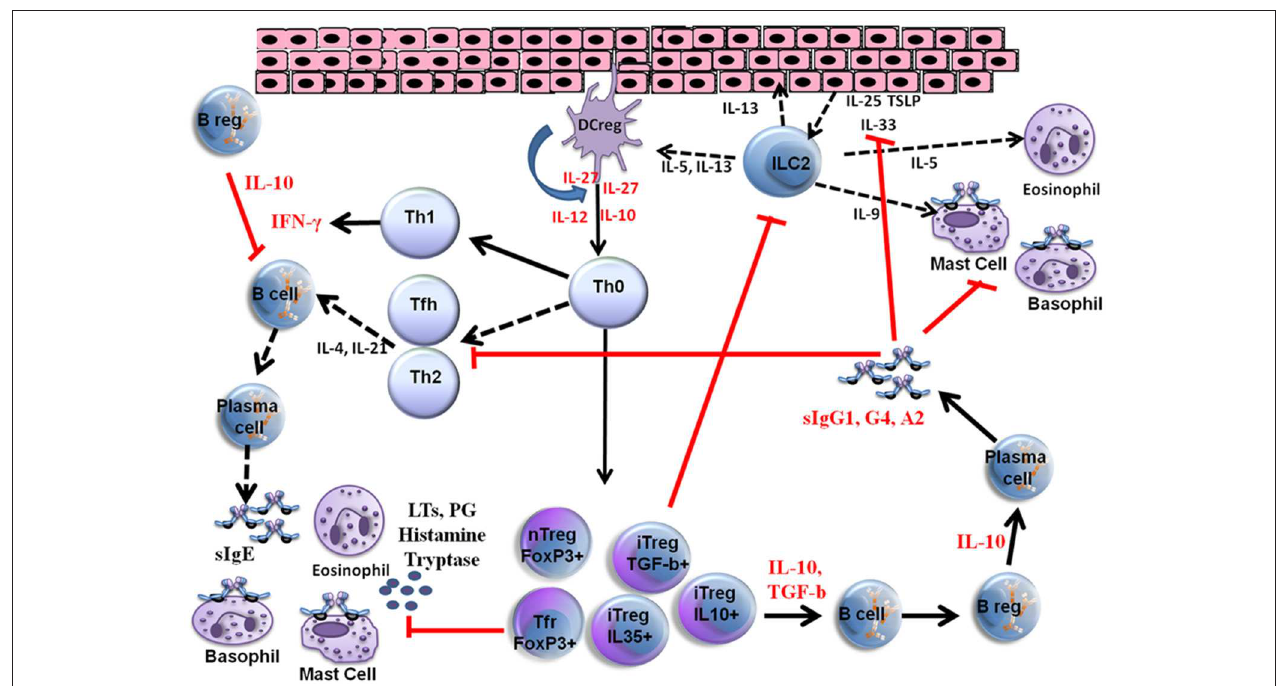
FIGURE 1 | Mechanisms of venom allergen immunotherapy. High dose of hymenoptera venom stimulates dendritic cells and induces Treg and B reg cells as well as other B cell subsets that produce allergen specific IgG1, IgG4, and IgA type bloking antibodies. Several cytokines also take place in the immune tolerance induction and as a result a shift from Th2 to Th1 type immune deviation occurs. Red arrows show blocking activity induced during VIT. LTs, Leukotrienes; PG, Prostaglandins; iTreg, Inducible Tregulatory cells; nTreg, Natural T regulatory cells; Tfh, T follicular hepler cells; Tfr, T Follicular regulatory cells; DC reg, Regulatory dendritic cells; TSLP, Thymic stromal